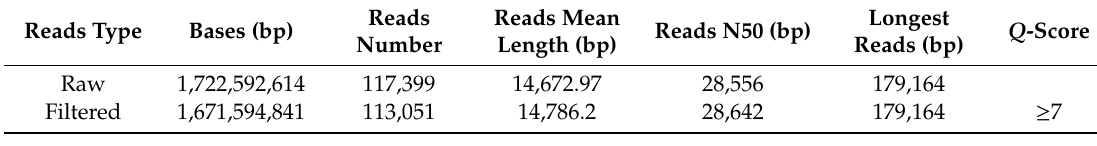
Table 1. Sequencing information of L. sakei via Nanopore.